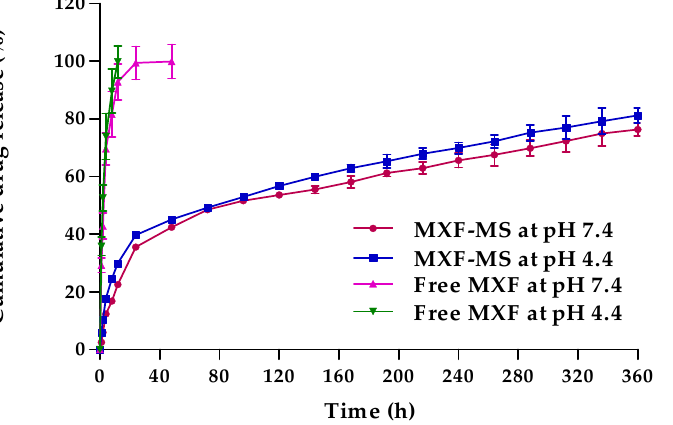
Figure 4. In vitro drug release profile of free MXF and MXF-PLGA-MS in acetate buffer (pH 4.4) and phosphate buffer (pH 7.4).